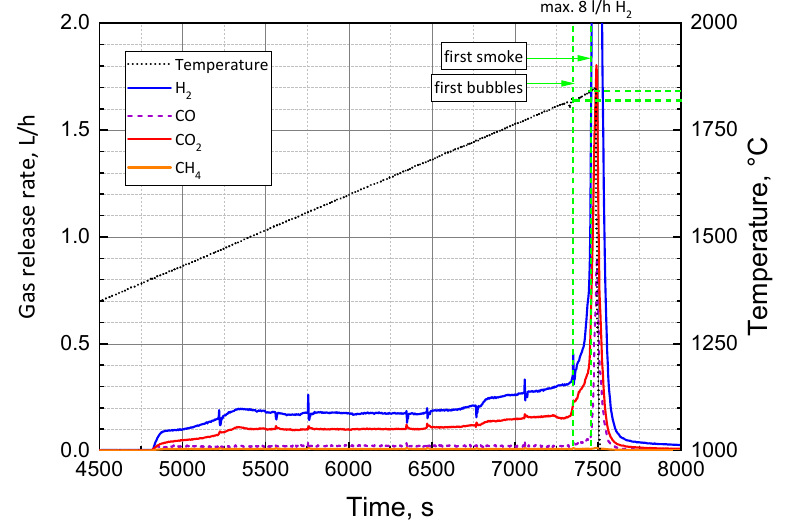
Figure 3. Temperature history and gas release rates during transient test SiC-01.